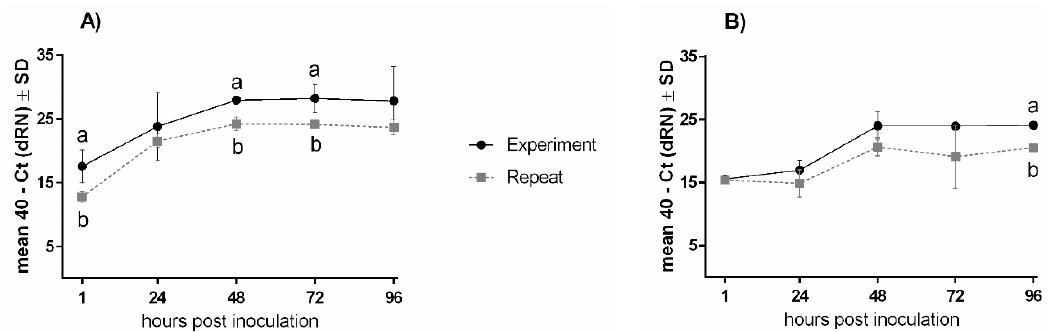
Figure 2. Comparison of AMPV-B viral genome in TOCs and OOCs between two experiment series. For each group, three to five rings were collected at 1, 24, 48, 72, and 96 hpi and processed for AMPV-B quantification in TOCs ( A ) and OOCs ( B ) using qRT-PCR. Normalised data are presented as mean 40 - Ct. Error bars represent standard deviations (SD). Small letters indicate significant differences between the two experiments for either the trachea or oviduct at the same time point ( A , B ), determined using two-sample t -tests. p -value < 0.05.